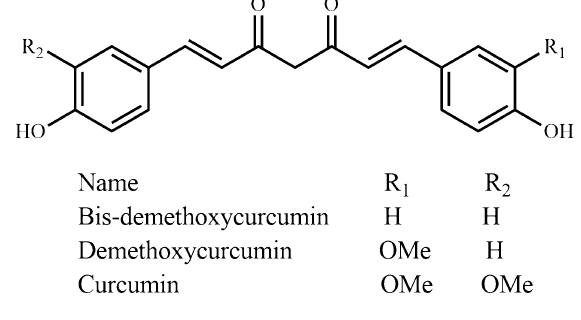
Fig. 13 Diphenylheptanoids